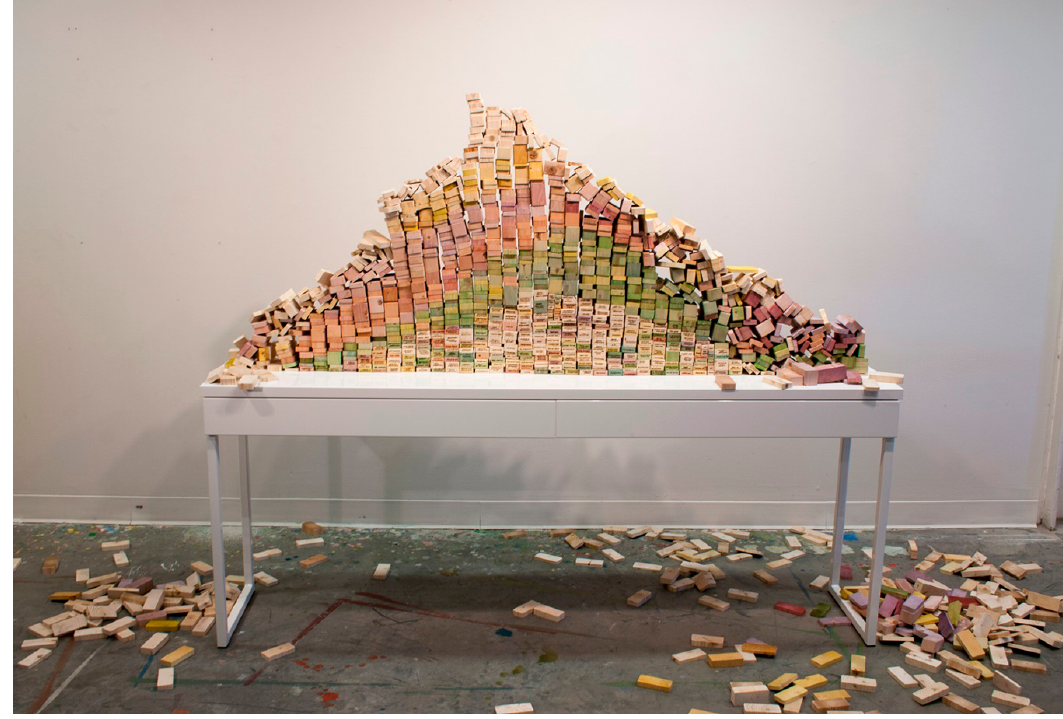
Figure 5. Seven Stages of ALS. Courtesy of the author.